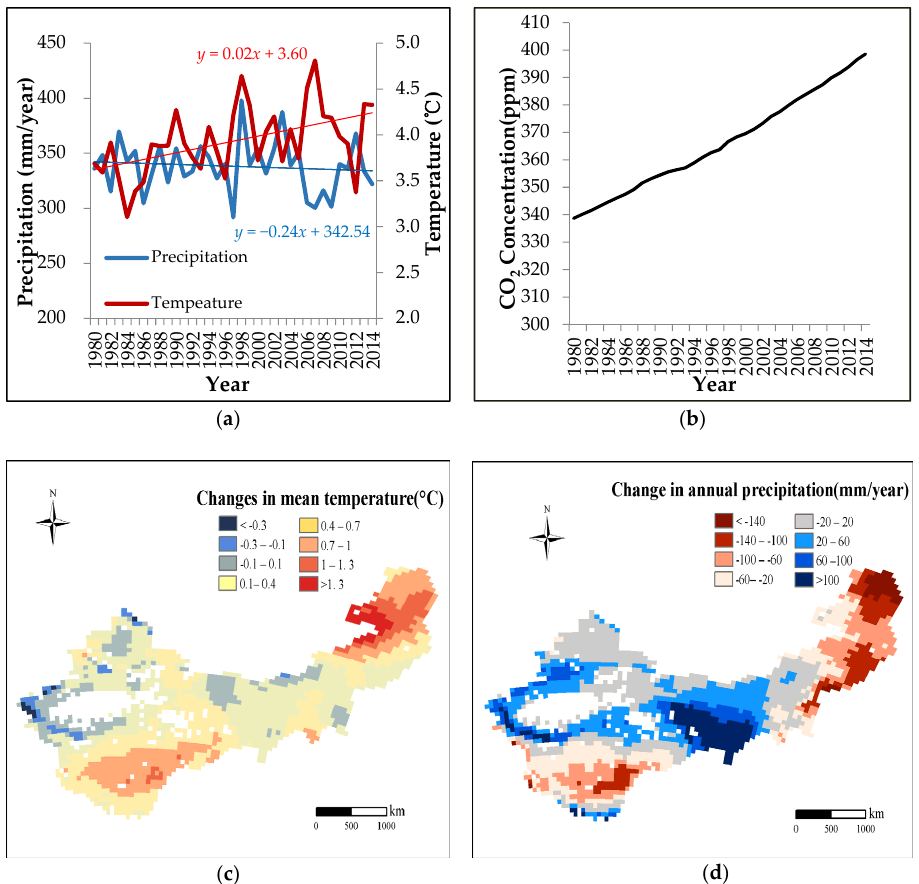
Figure 3. The temporal patterns of ( a ) climate factors and ( b ) CO 2 and the spatial patterns of the changes (calculated by subtracting the averages from 1980–1997 from the averages from 1997–2014) in ( c ) temperature and ( d ) annual precipitation from 1980 to 2014 in ASA ‐ China.